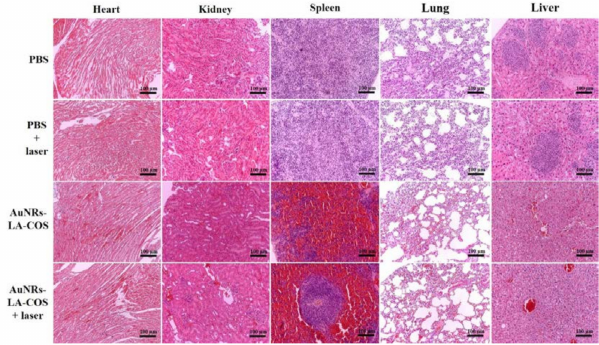
Figure 8. Histology staining of major organs collected from different groups of mice 20 days after NIR laser